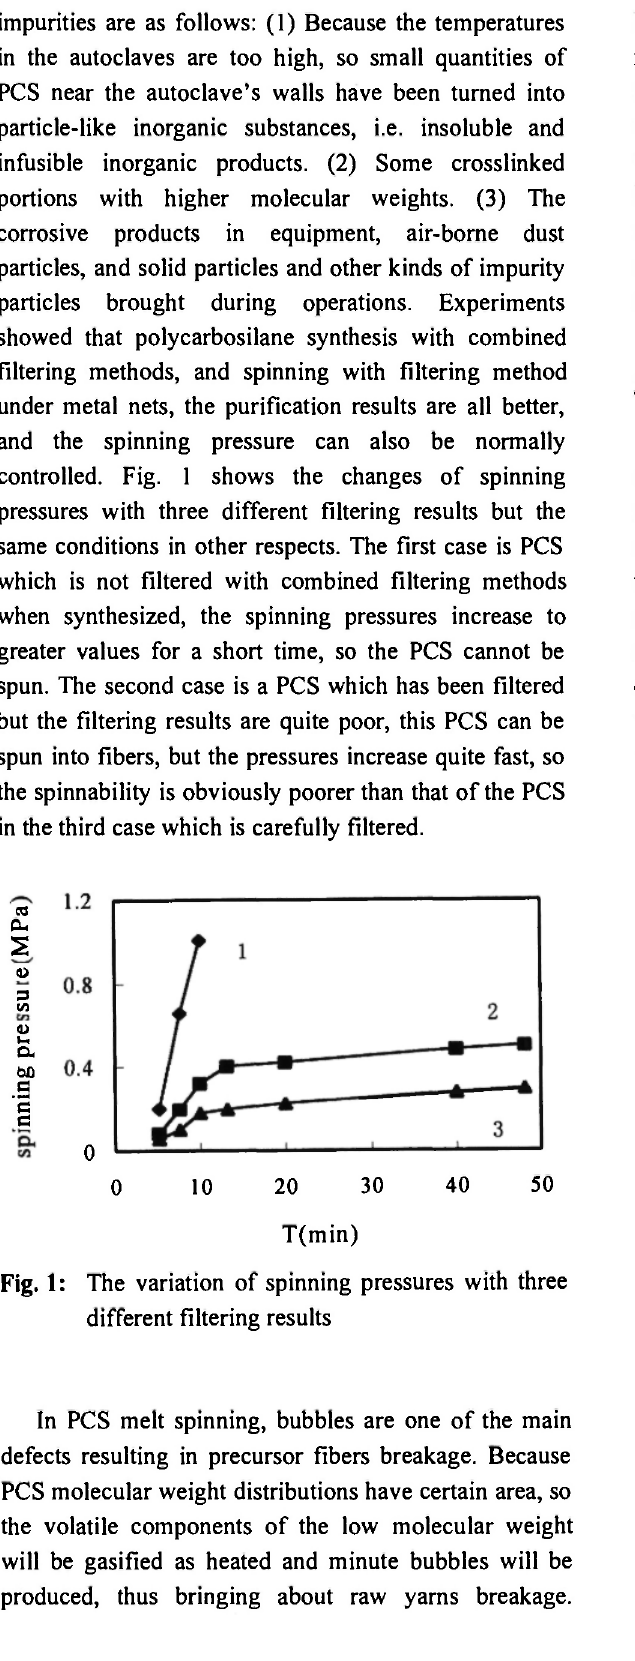
Fig. 2: The relation between spinning temperature and fiber